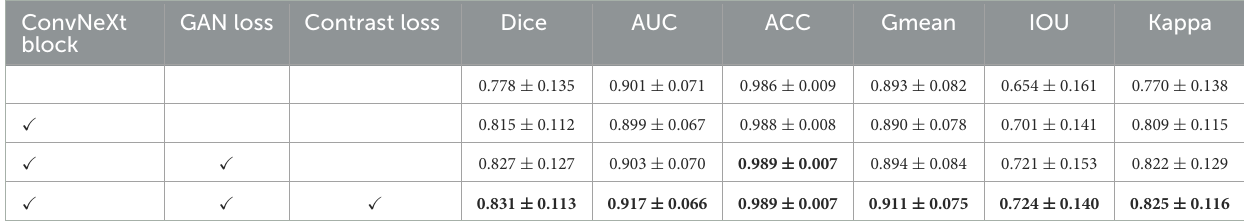
TABLE 3 Ablation studies of our segmentation method in TEE images. ConvNeXt